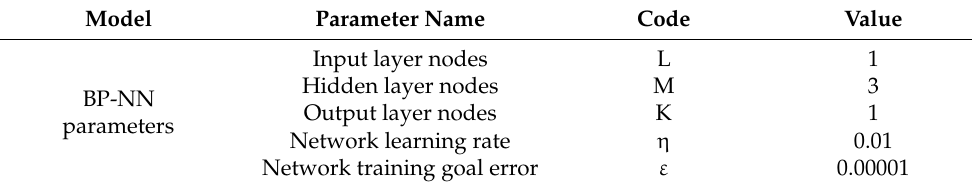
Table 4. BP NN model